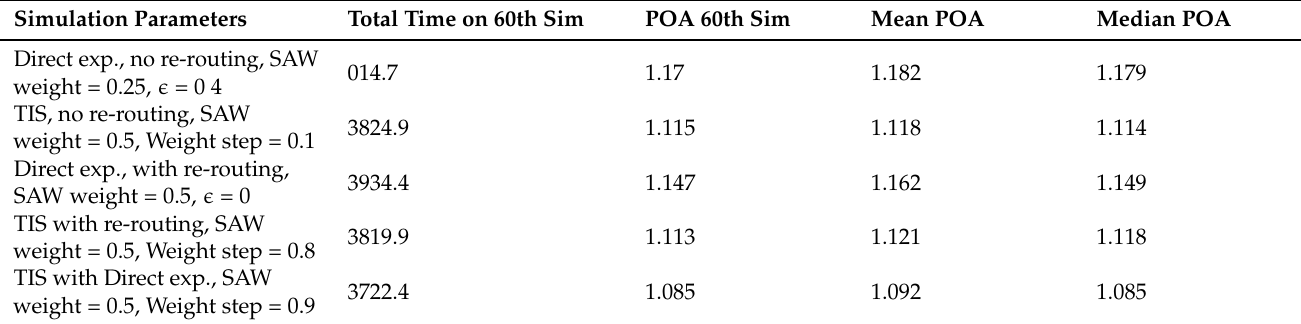
Table 1. Parameters by method with lowest median Price of Anarchy (POA),